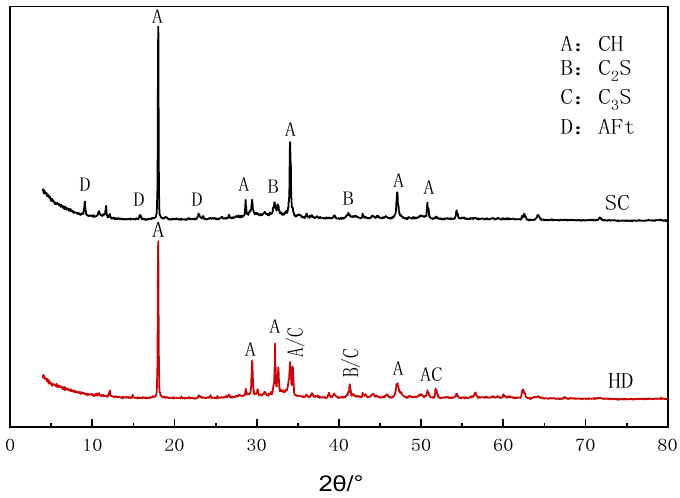
Figure 7. The XRD patterns of FA0-P under different curing systems.